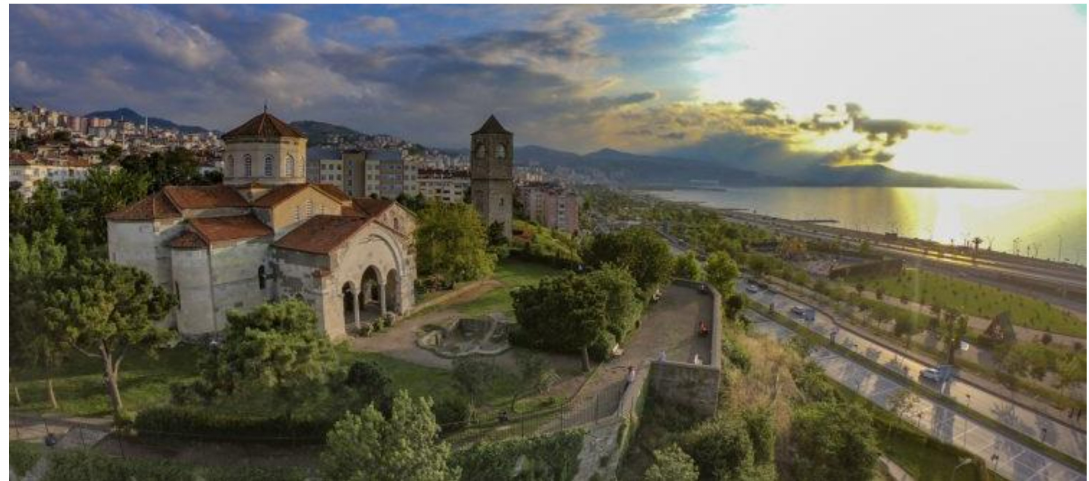
Figure 9. Trabzon Hagia Sophia